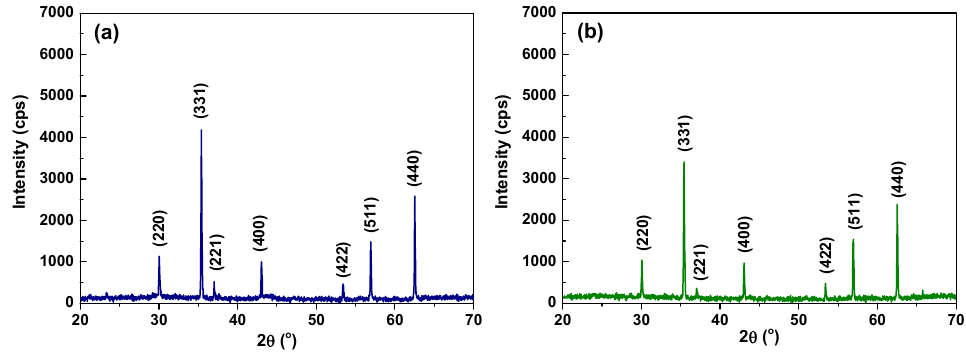
Figure 8. XRD patterns of deposits on SG tubes: ( a ) Alloy 600 and ( b ) Alloy 690.